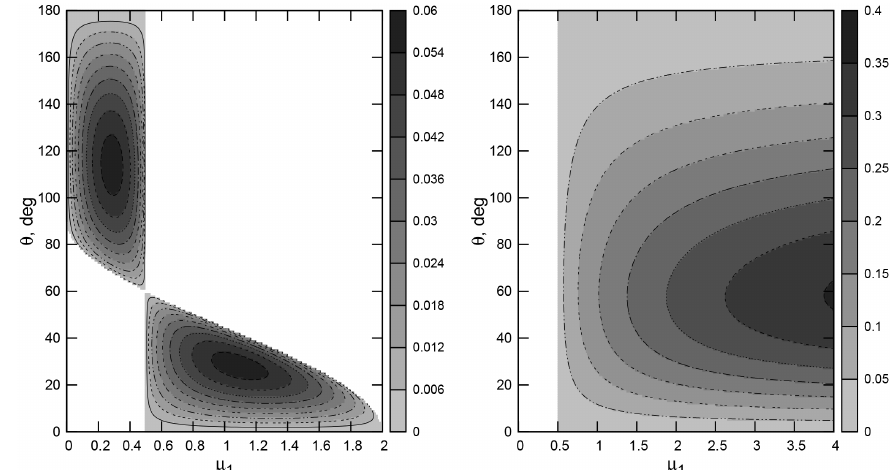
Figure 2. The same as in Fig. 1 but for µ p = 0 . 5.